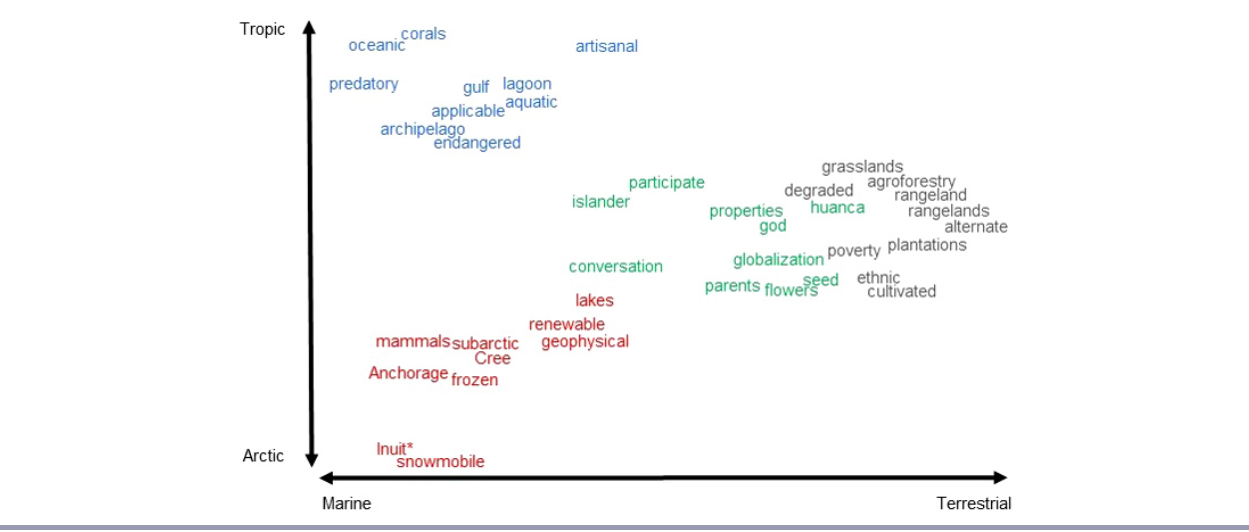
Fig. 4 . Research clusters resulting from detrended correspondence analysis: research in Arctic environments (red), research in terrestrial environments (green), research in coastal environments (blue), and research in grass and rangeland environments (gray). *wording